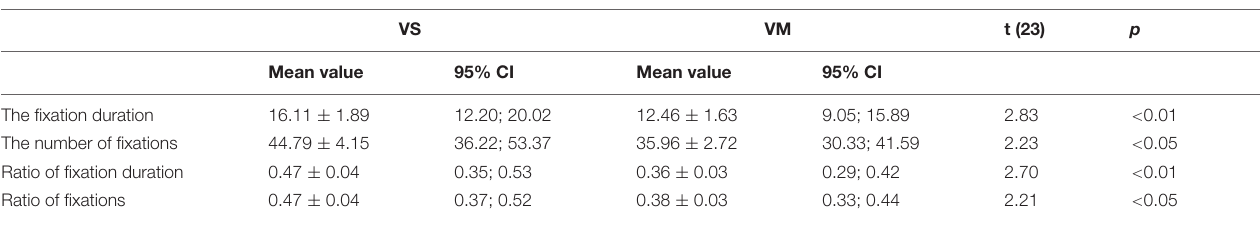
TABLE 1 | Visual perception data on Musa basjoo